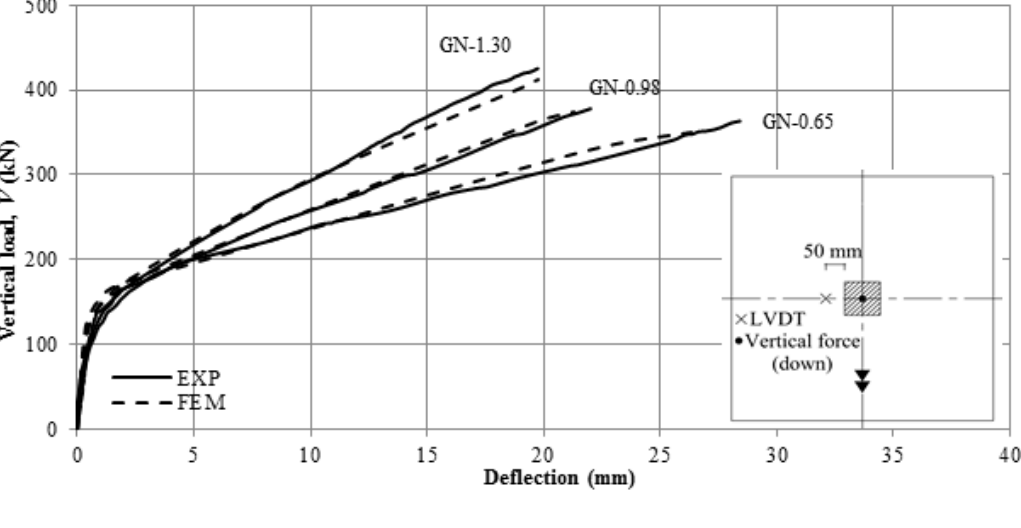
Figure 6. Load-deflection relationship.